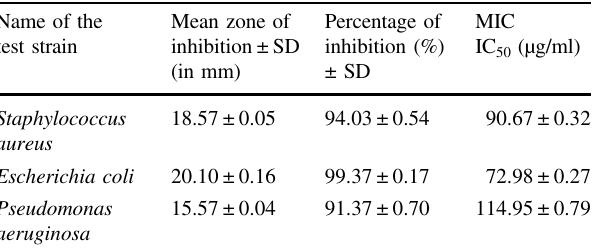
Fig. 6 FE-SEM micrographs of untreated E. coli cells ( A ) showing intact and high electron density morphology (green arrow). ( B ) The considerable size of adhered nanocomposites was observed (brick red arrow) attached to the surface of the cells of the bacteria, and disrupted cell wall and membrane leakage was observed. The scale bar is 5 μ